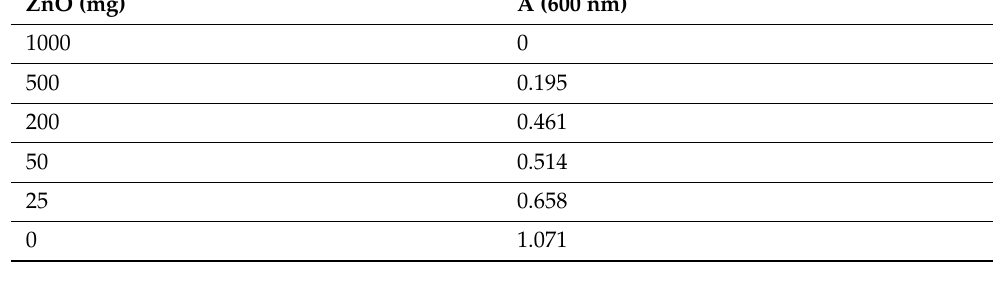
Figure 3. Inhibition Zone produced by green biosynthesized ZnO NPs against S. aureus and E. coli bacteria (the reported values are average and based on four measurements). Table 1. The value of absorbance for E. coli bacteria in various dosages of green biosynthesized ZnO NPs.